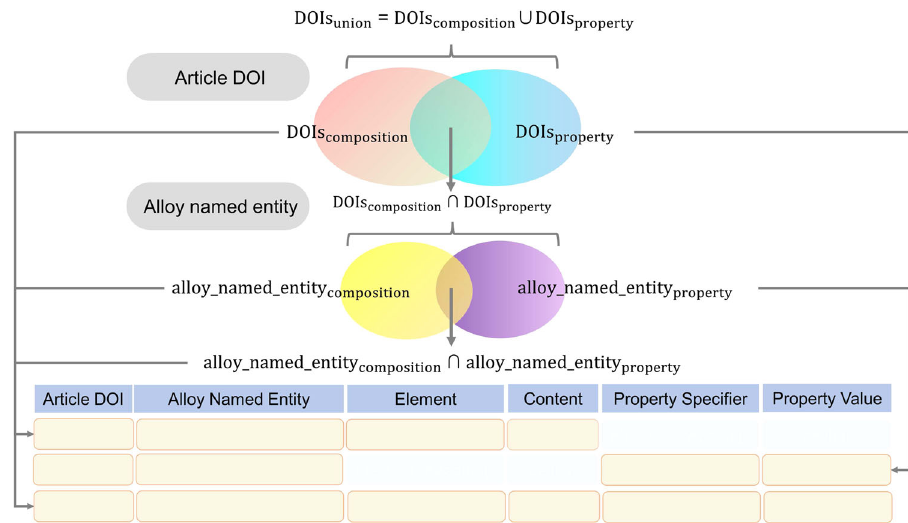
Fig. 5 Schematic of interdependency resolution algorithm by divide and conquer strategy. To merge the fragments of chemical composition and property, the instances of the same alloy named entity with the same article DOI are joined into a complete record in a 6-Tuple: <article DOI, alloy named entity, element, content, property_speci fi er,